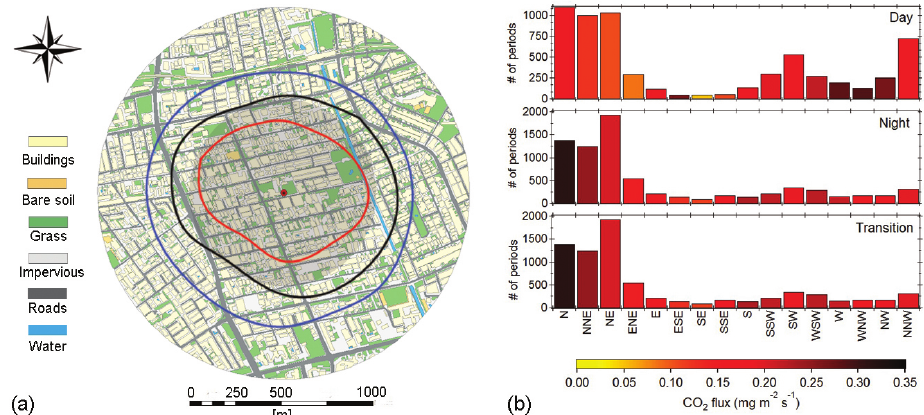
Fig. 1. (a) Footprints encompassing 80% of the EC flux source area overlaid on a land cover map centered on the EC tower location (red dot) and (b) number of EC 30min periods (after data post-processing and quality control) during the study period as a function of wind direction for three periods of the day. Red, blue and black contours in (a) are average footprints for each wind direction during Day (08:00–18:00 h), Night (20:00–06:00 h) and the complete diurnal course, respectively. Transition period in (b) is defined as two hours centered on sunrise and sunset, respectively. Shaded area in (a) represents the 500m radius domain used for estimating the bottom-up emissions. The colour of bars in (b) indicates the average CO 2 flux observed for each wind direction sector